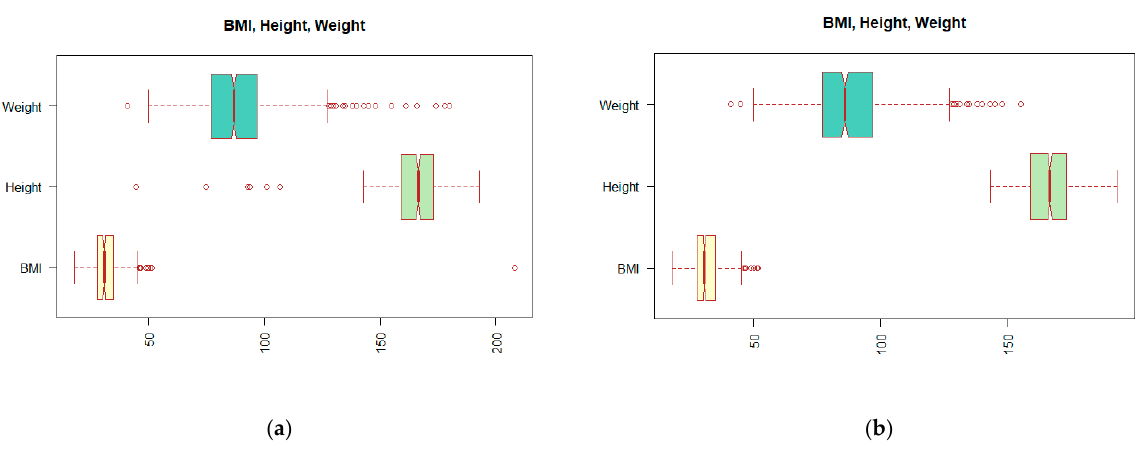
Figure 2. Display boxplots for attributes BMI (body mass index), Height, and Weight: ( a ) before outlier treatment; ( b ) after treatment of the outliers.